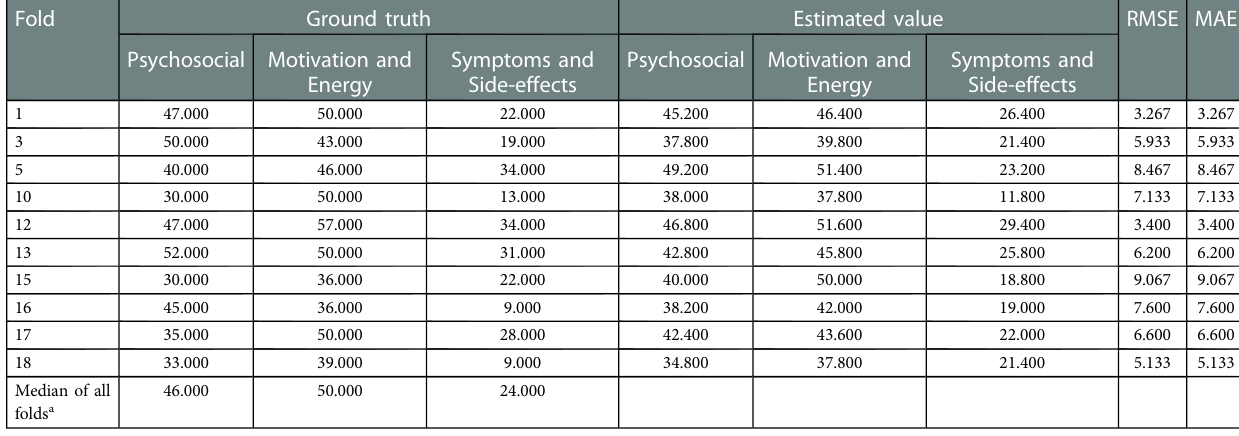
Table 8 Ground truth and estimated values for each subject with RMSE less than 10.